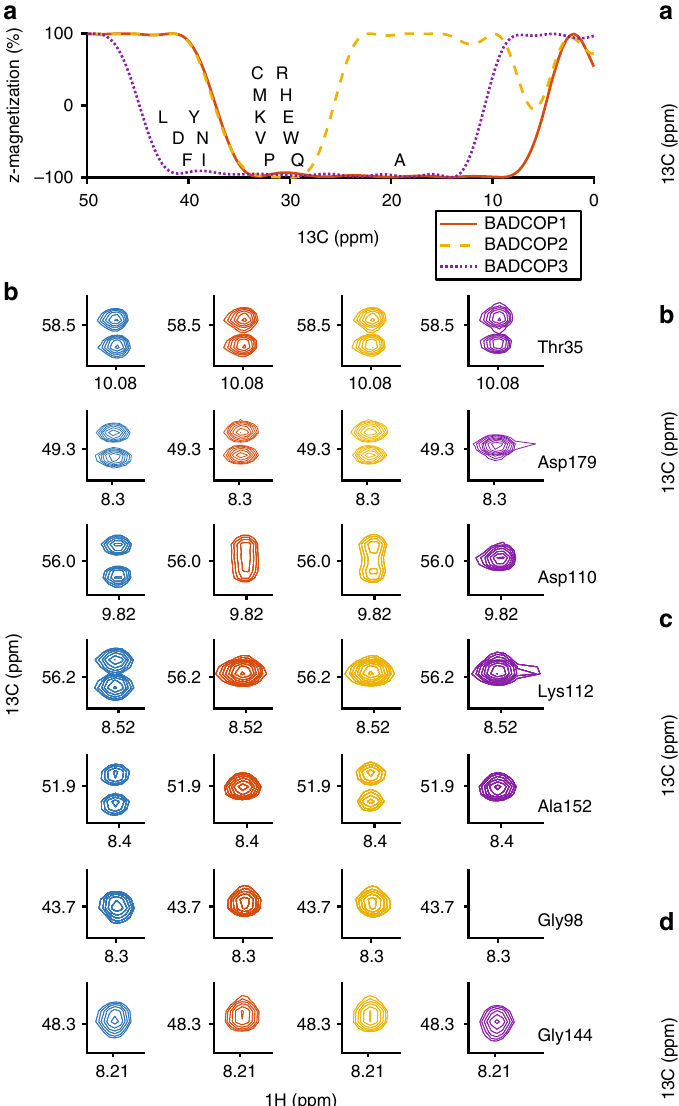
Fig. 3 Experimental observation of amino acid-speci fi c line shapes using BADCOP1 – 3. a Simulated C β inversion pro fi les with the three decoupling pulses BADCOP1 – 3. The initial state is ρ (0) = I z , and the fi nal longitudinal magnetization is depicted. The mean C β chemical shift from the BMRB is indicated for the various amino acids. b Peaks selected from four 2D HNCA planes of HCAii, acquired with the standard pulse program (left column) and with the three different optimized decoupling pulses (columns 2 – 4; BADCOP1 – 3). The same peak is represented in each row. The peaks are either singlets or doublets depending on C β chemical shift. Therefore, the patterns code for the C β and indirectly for the amino acid type. The selectivity is not perfect in all cases (due to secondary shifts moving the C β ). Note that there are no Bloch – Siegert shifts; all peaks appear at the correct C α position (i.e., the same as the standard sequence in the leftmost column). Of particular interest is the loss of up fi eld glycine C α (row 6) using BADCOP3 and the slightly different line shape patterns between the two aspartic acid C α , indicating different C β chemical shifts (rows 2 and 3). The alanine pattern is unique (row 5). All acquisition, processing, and display settings are the same for the four